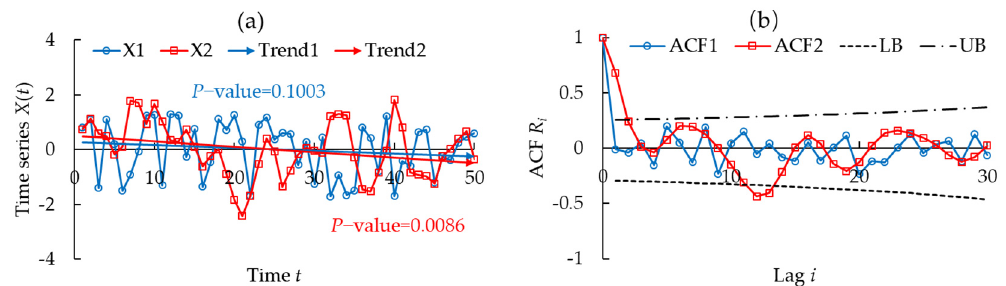
Figure 2. Random time series and their trends ( a ) and ACFs ( b ). (Note: X1 and X2 are independent and dependent random time series, respectively; X1 and X2 have the same length (50), the same average value (0), and the same variance (1); Trend1 ( p -value = 0.1003) and Trend2 ( p -value = 0.0086) are trends of X1 and X2, respectively; ACF1 and ACF2 are the ACFs of X1 and X2, respectively; and LB and UB are the lower and upper bounds of insignificant autocorrelation coefficients, respectively, at 5% significance level).